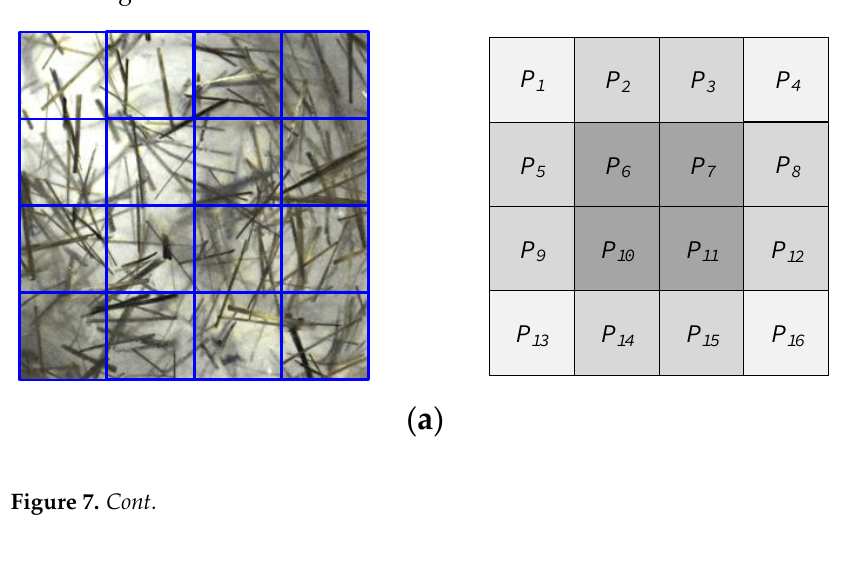
Figure 6. Binary images of the BF distribution pattern in transparent model with different BF dosages. In order to identify BF’s scattered morphological characteristics in the visual field, the joint blocking method was used, as shown in Figure 7, and the image of the transparent model was divided into 4 × 4 blocks: